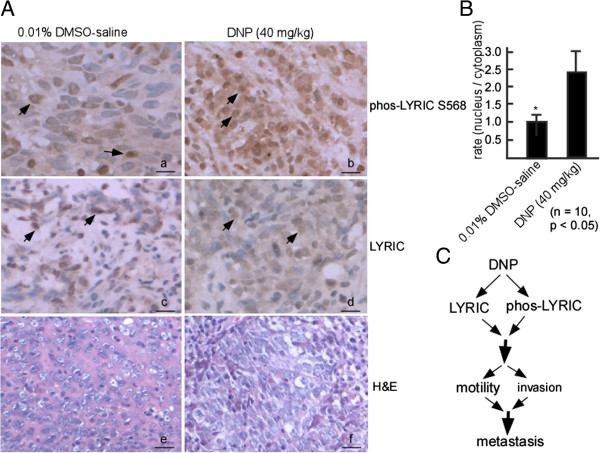
Phospho-LYRIC and LYRIC expression in the metastatic tumors induced by DNP. The metastatic tumor samples were embedded. Tissue sections of 4-μm thickness were prepared, and deparaffinized in xylene, and rehydrated in a graded alcohol series. Phospho-LYRIC and LYRIC were detected in these sections using immunohistochemistry. A, Paraffin sections were stained with hematoxylin and eosin as well as with antibodies against or LYRCI or phospho-LYRIC S568. a, c and e, The untreated 6-10B cells (NPC in situ) used as control; b, d and f, The DNP-treated 6-10B cells. Arrow, positive cell. Magnification, × 400. Scale bar, 5 μm. H & E, hematoxylin and eosin. B, Phospho-LYRIC was quantified in the nucleus and cytoplasm of metastatic tumor cells by using ImageMaster software, and phospho-LYRIC rates of nucleus to cytoplasm were calculated. C, Schematic illustration of DNP-induced metastasis. DNP-mediated LYRIC phosphorylation increases the motility and invasion, leading to metastasis of NPC cells.